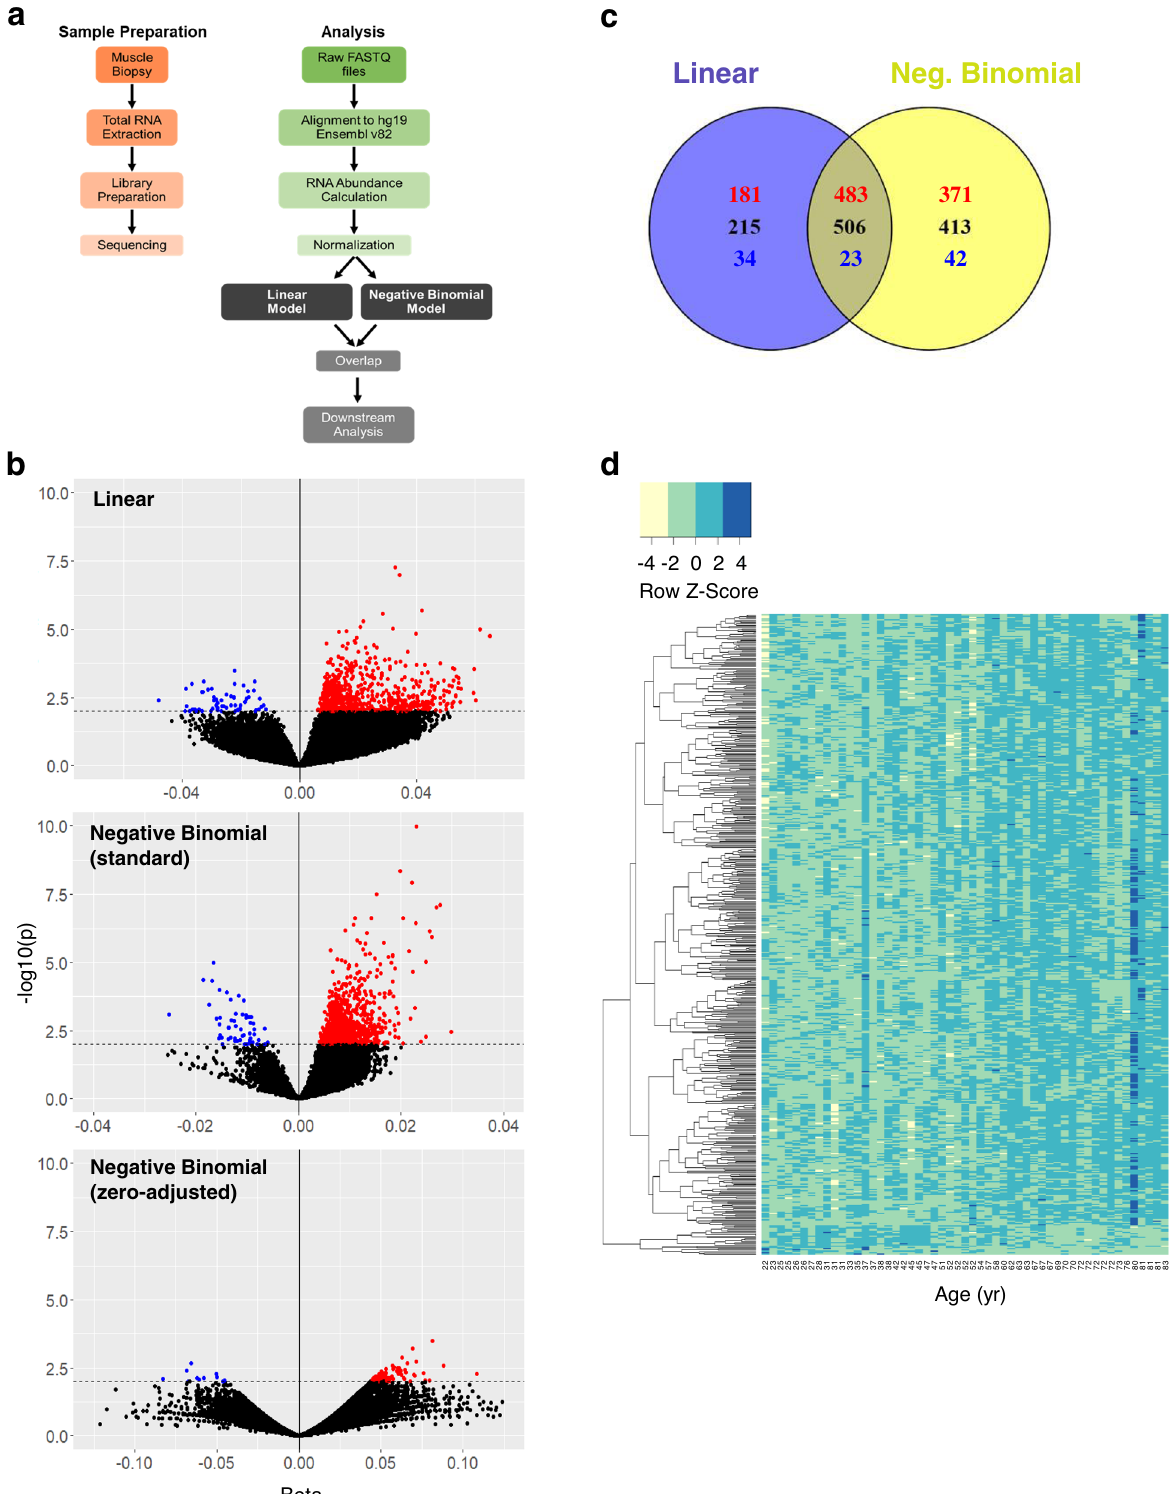
Our analysis also con fi rmed RNA (ENSG) expression patterns with aging, previously identi fi ed in the literature, including FAM83B (Family with Sequence Similarity 83 Member B, involved in hypoxia response 14 ), C12orf75 (chromosome 12 Open Reading Frame 75, implicated in insulin signaling and energy metabolism 15 ), SKAP2 (Src Kinase-Associated Phosphoprotein 2, which